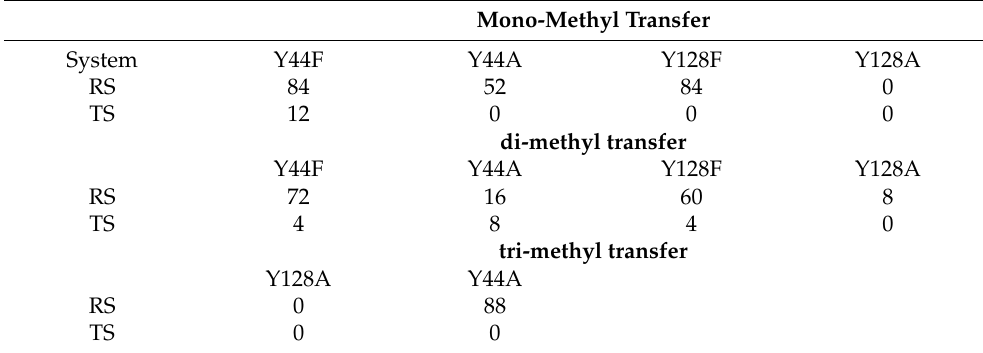
Table 5. Values represent the percentage (%) of systems from the set of 25 conformers of each mutant state where N ε (K4) from the lysine interacts with a water molecule at the RS and TS. Mono-Methyl Transfer System